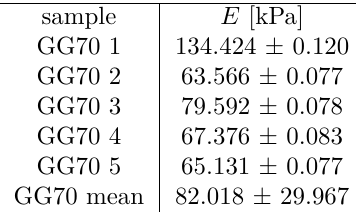
Table 4. Elastic properties of GG samples with 50 wt% BAG for tensile test